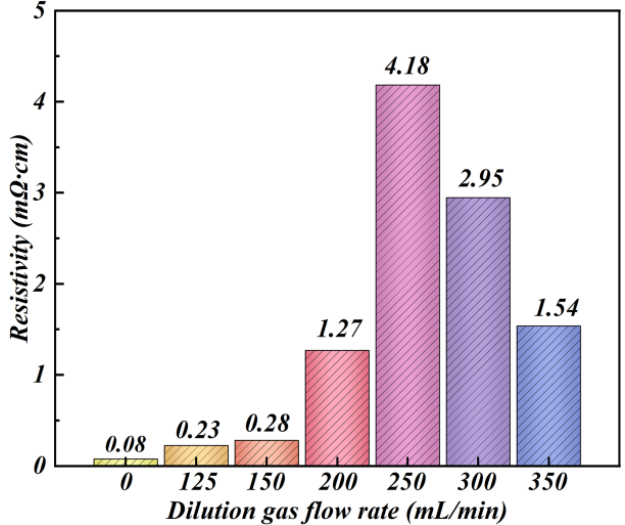
Figure 7. Bulk material’s electrical resistivity for Fe–Si compacts and Fe–Si/SiO 2 soft magnetic